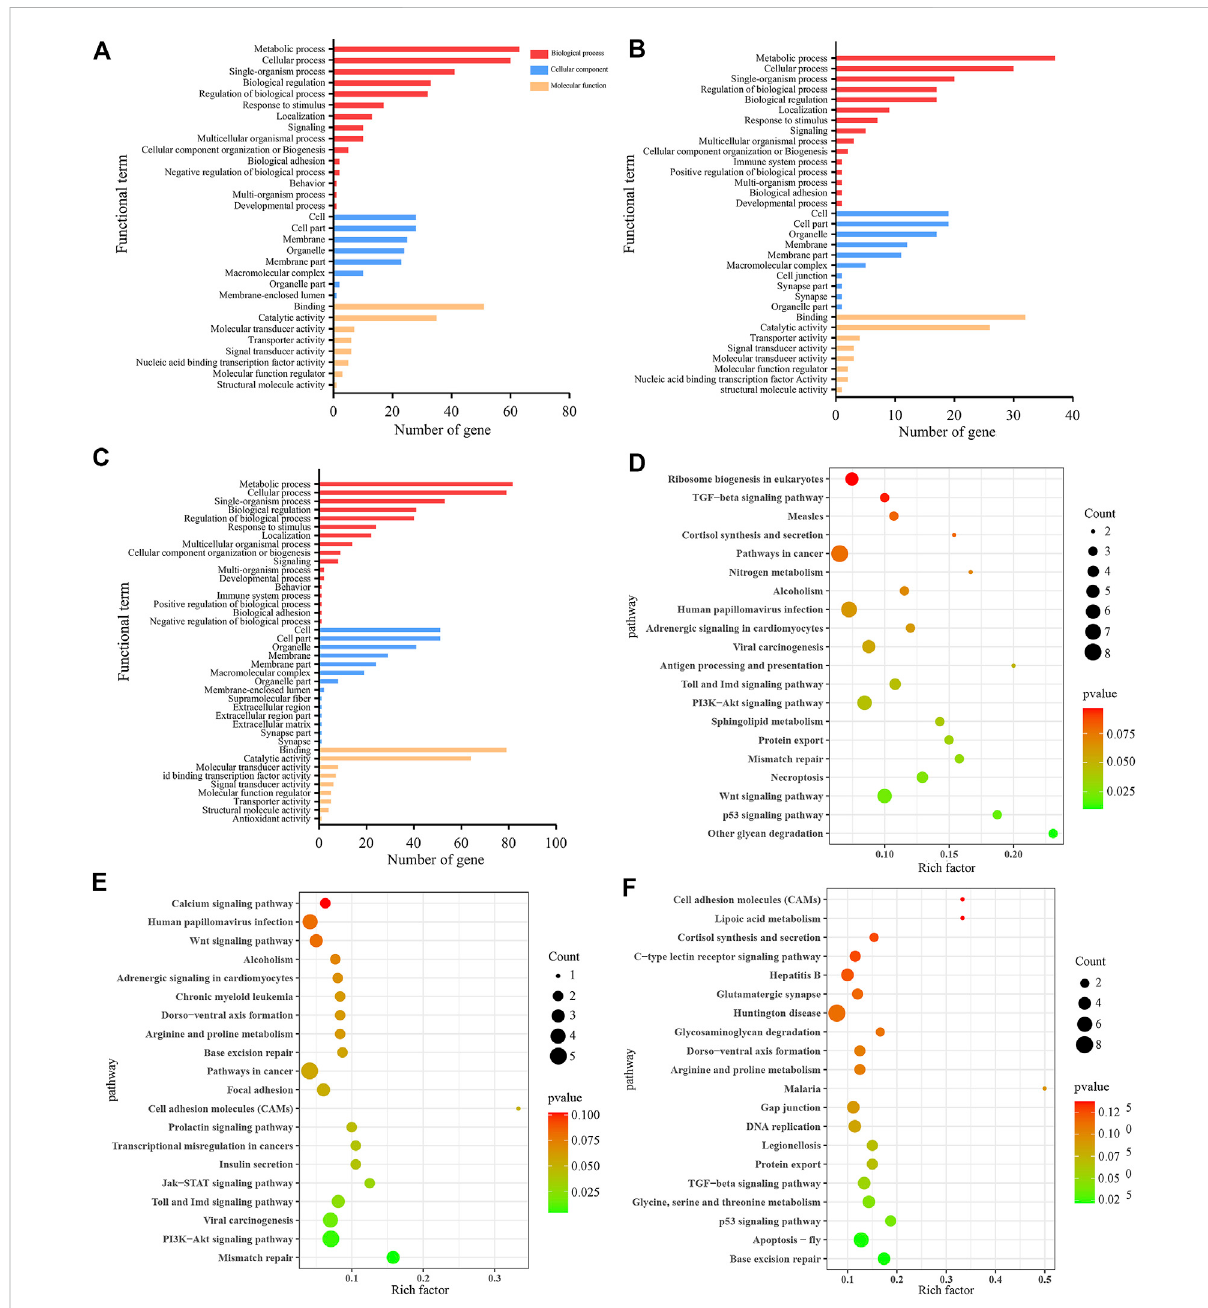
GO terms and KEGG pathways enrich by neighboring genes of DElncRNAs. (A – C) GO classi fi cation of neighboring genes of DElncRNAs in AmCK1 vs. AmT1, AmCK2 vs. AmT2, and AmCK3 vs. AmT3 comparison groups. (D – F) Enriched KEGG pathways by neighboring genes of DElncRNAs in AmCK1 vs. AmT1, AmCK2 vs. AmT2, and AmCK3 vs. AmT3 comprison